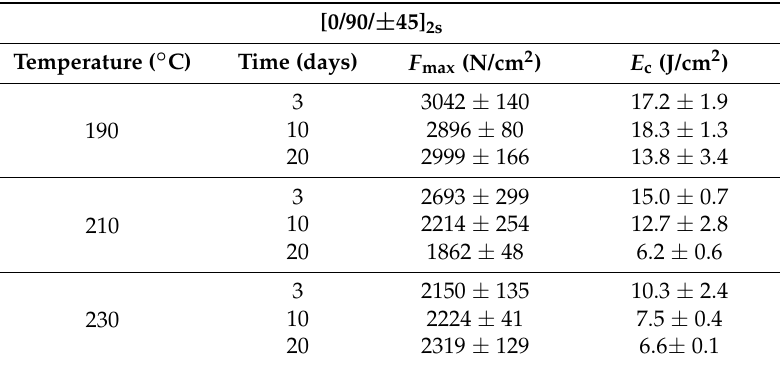
Table 6. Average maximum force and impact strength results of quasi-isotropic [0/90/ ± 45] 2s laminates subjected to an impact energy of 32.46 J after different ageing treatments ( T ≈ T g and T > T g ). Standard deviation is included.